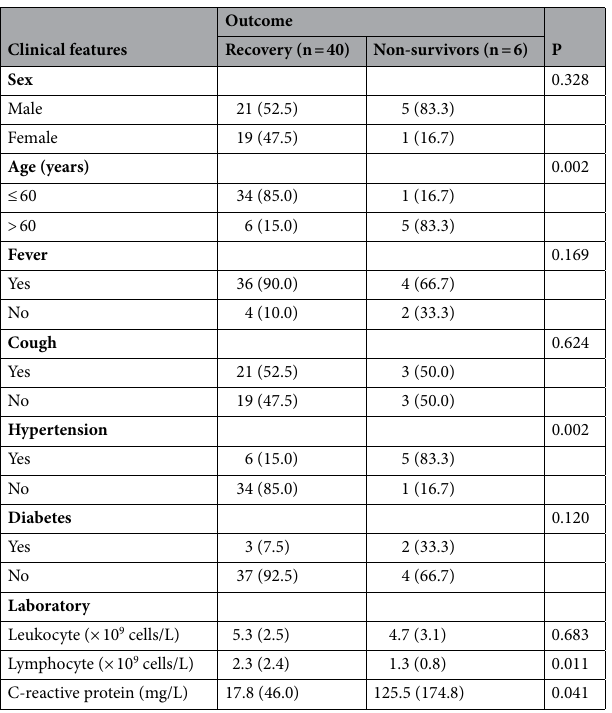
Table 1. Comparison of final outcome according to clinical characteristics. Continuous data presented as median (IQR) and categorical data as n (%).